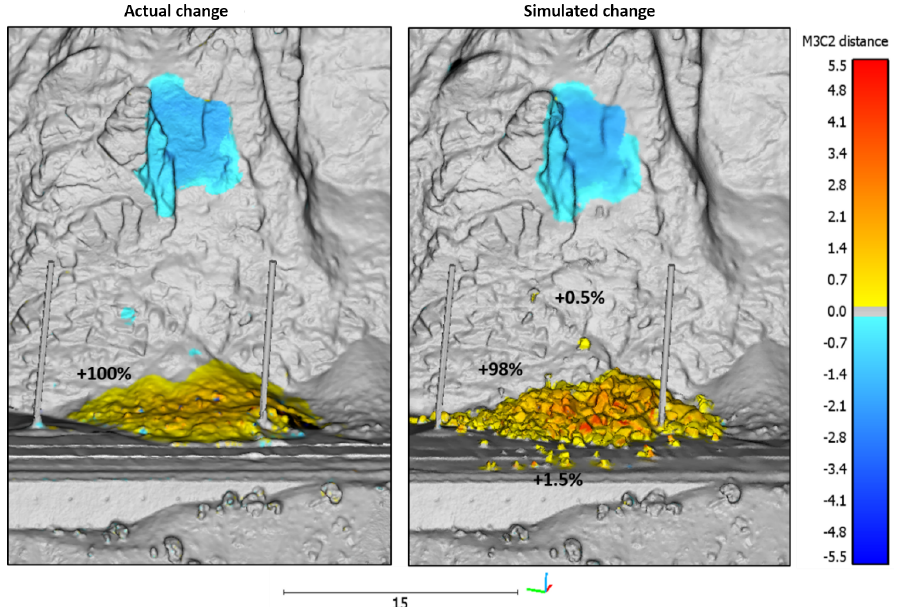
Figure 15. A comparison of the actual and simulated change detection results from the 32m 3 flexural toppling event from White Canyon East, Site C. The simulation produced a good comparison with the actual change detection results, yielding a similar spatial distribution, and magnitude of change. The percentage of initial source volume retained at various locations on the actual and simulated slope is shown. The majority of the material in both cases is retained in the track-side ditch. In the simulated case a small amount of the simulated volume comes to rest on the slope (0.5%) and runs out into the track area (1.5%).